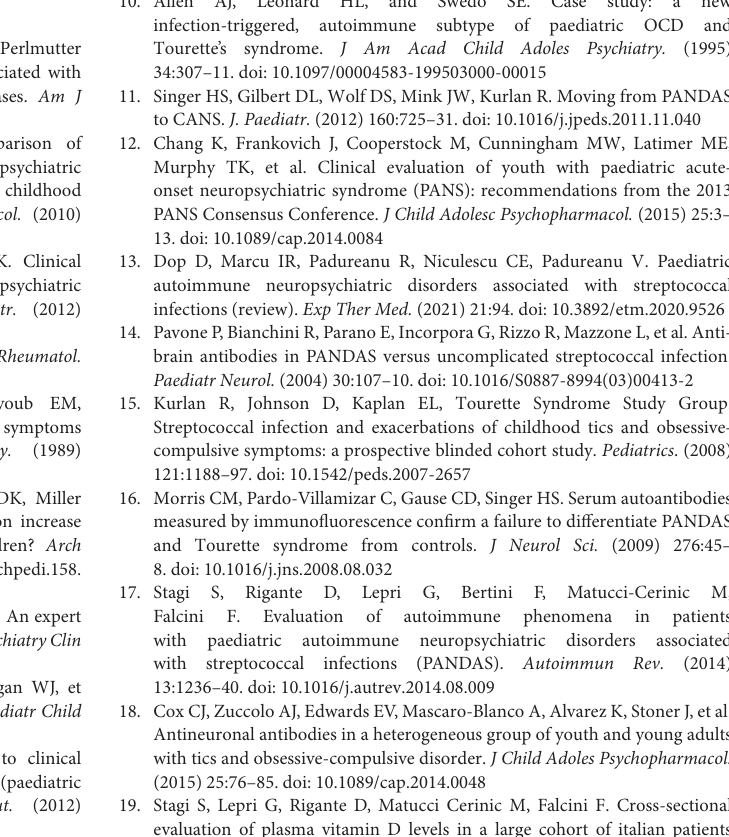
Supplementary Figure 1 | Proposed test panel for patients with suspected PANDAS and related